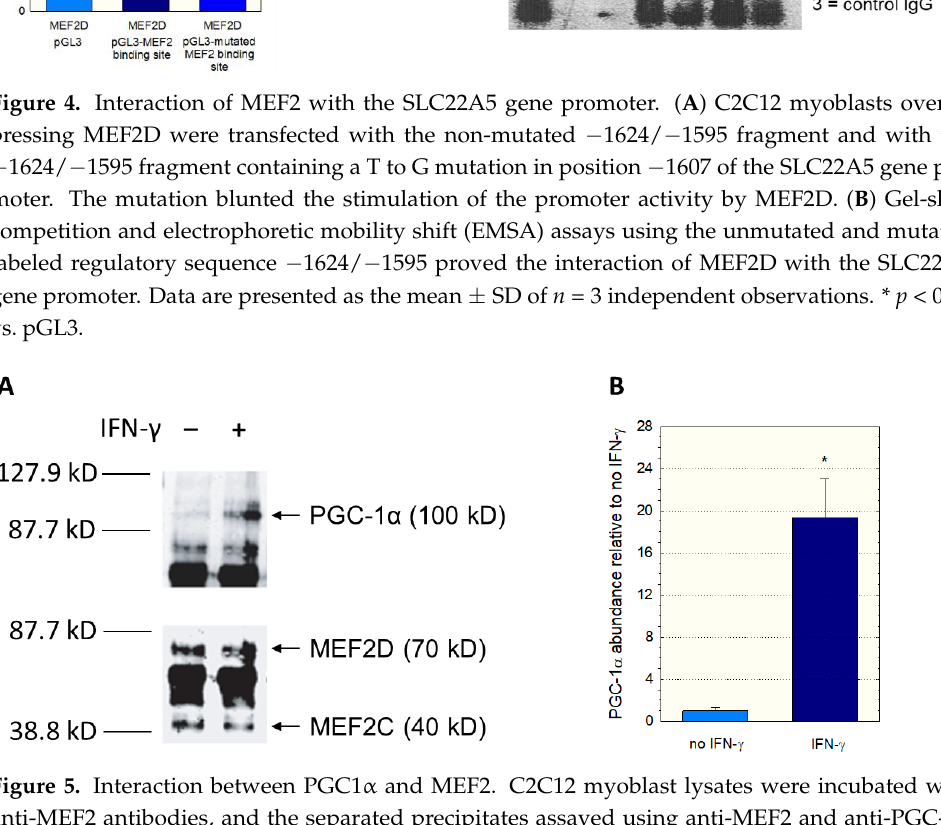
Figure 4. Interaction of MEF2 with the SLC22A5 gene promoter. ( A ) C2C12 myoblasts overexpress- ing MEF2D were transfected with the non- mutated −1624/−1595 fragment and with the −1624/−1595 fragment containing a T to G mutation in position −1607 of the SLC22A5 gene promoter. The muta- tion blunted the stimulation of the promoter activity by MEF2D. ( B ) Gel-shift competition and elec- trophoretic mobility shift (EMSA) assays using the unmutated and mutated labeled regulatory se- quence −1624/−1595 pro ved the interaction of MEF2D with the SLC22A5 gene promoter. Data are presented as the mean ± SD of n = 3 independent observations. * p < 0.05 vs. pGL3.